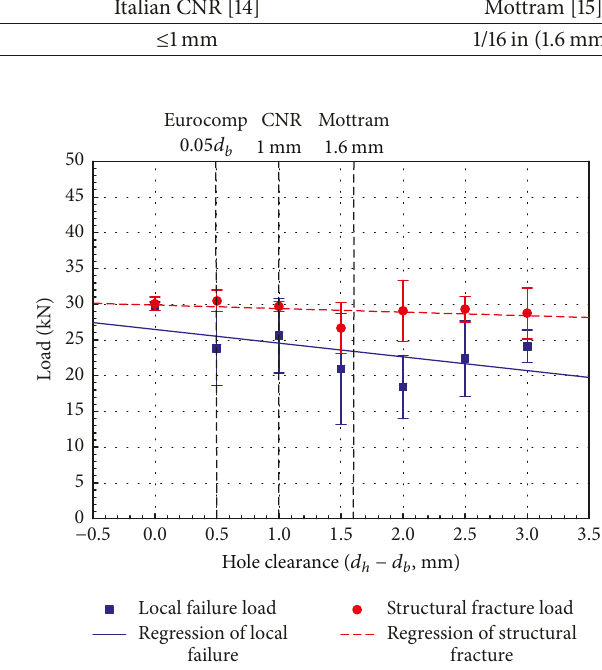
Figure 12: Relationship between load and bolt-hole clearance (specimen from angle).